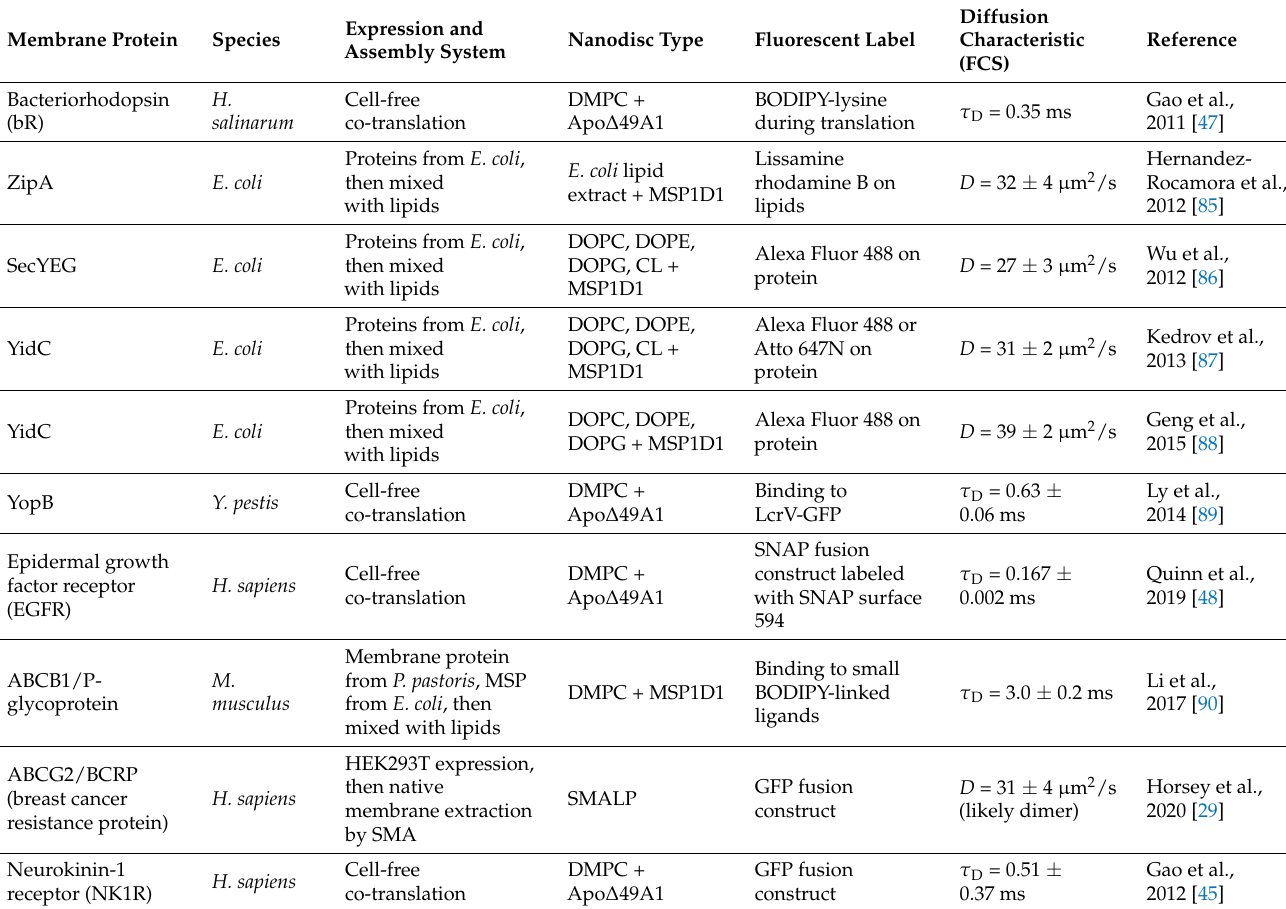
Table 1. Membrane proteins embedded in nanodiscs and studied by